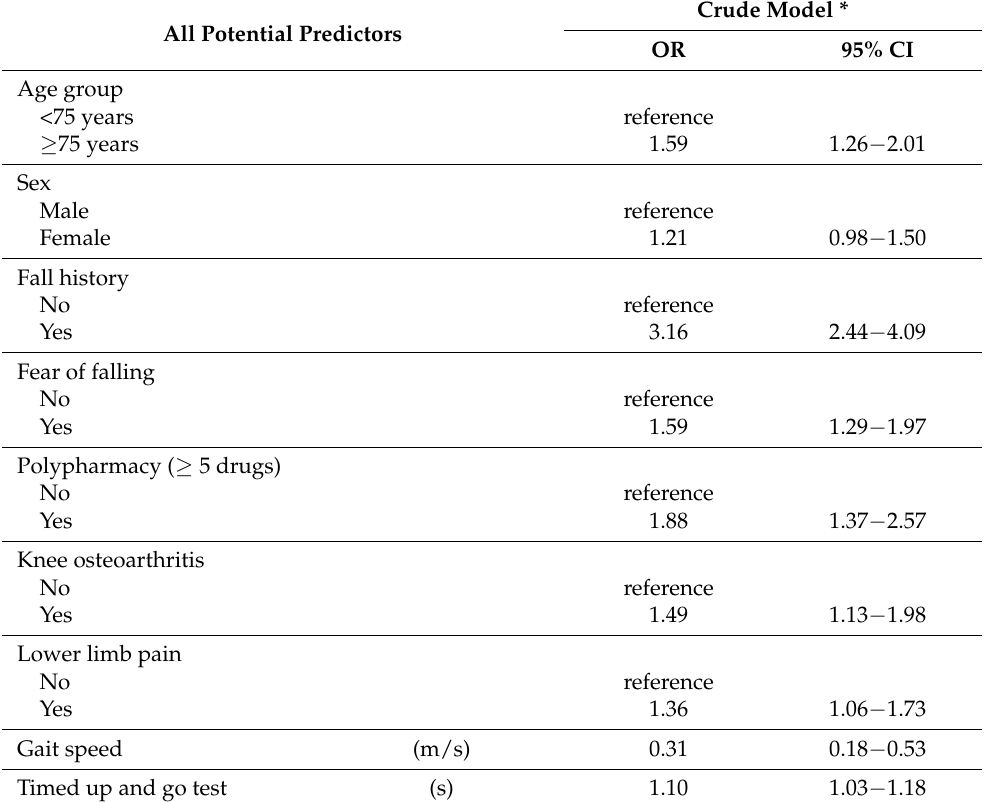
Table 2. ORs of potential predictors for